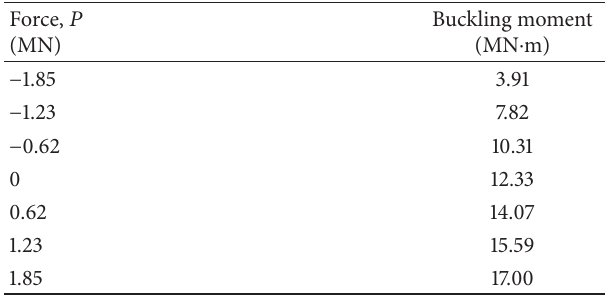
Table 5: Critical buckling moment for cantilevered boundary condition with varying compressive force (5-element DFE model).